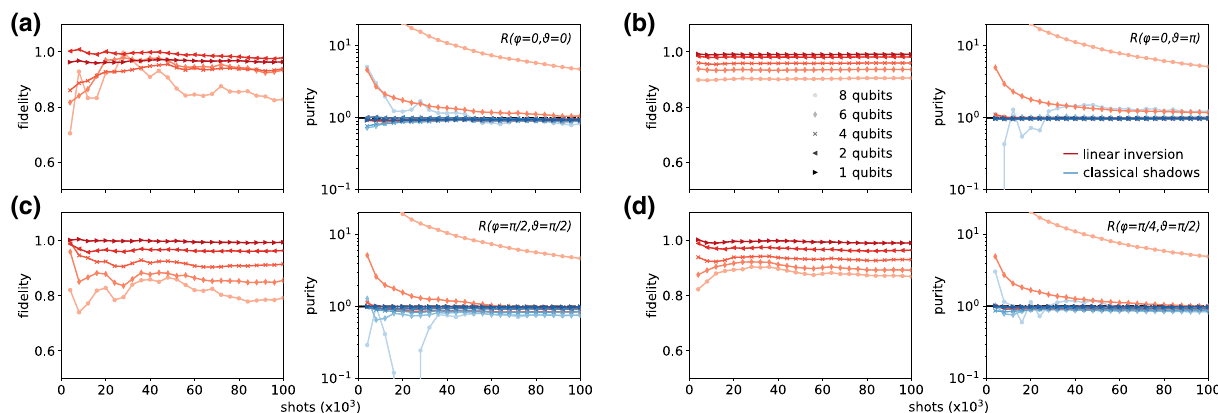
FIG. 13. Experimental convergence investigation of local states with different orientation, i.e., basis overlap. The given states are collectively prepared on eight qubits and partially traced to study multiple subsets. (a) The | 0 (cid:4) state perfectly aligned with the first SIC vector. (b) The | 1 (cid:4) state orthogonal to the first SIC vector, whose component completely vanishes. Convergence in (b) is significantly faster than in (a) as only three of the nonorthogonal SIC vectors take part. Boosted convergence is related to unambiguous state discrimination [62], limiting nonorthogonal measurements. (c) Superposition state with maximized overlap with one of the SIC vectors. (d) Superposition state with minimum overlap with the SIC vectors. Here, convergence of the state in (d) is better than (a) as the state’s information is more regularly distributed over the SIC vectors, not favoring one, resulting in a higher information gain. Also, note that the achievable fidelity generally drops with higher qubit number due to experimental